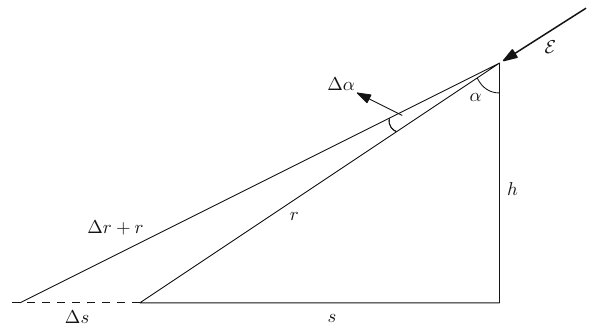
Fig. 1 The positrons move along the cone with angle Δα and inclina- tion angle α with respect to the vertical direction. The angular spread Δα (cid:9) α is assumed to be small. The spatial spread on the surface is determined by Δ s , while the additional travelling path is determined by Δ r , see estimates in the text. The altitude is assumed to be within conventional range h (cid:6) (4–12) km. Instant direction of the electric field E at the moment of exit of the positrons is also shown. Figure adapted from